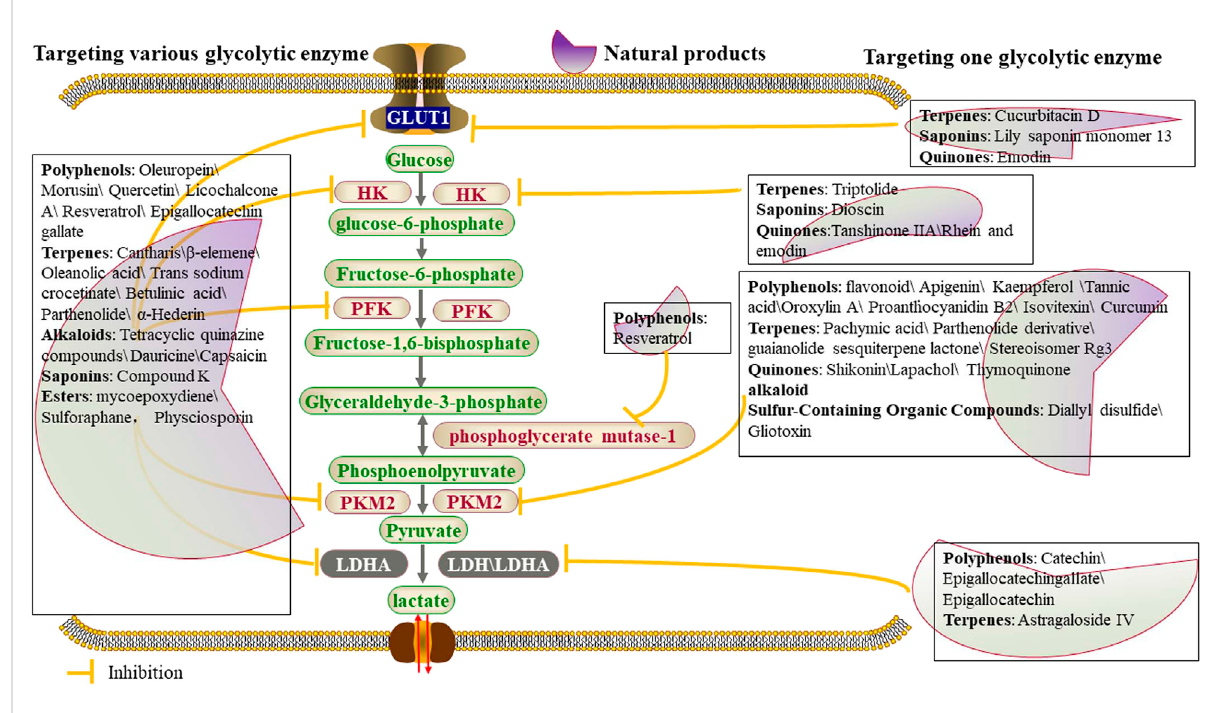
FIGURE 2 Natural products affect glycolysis in tumor cells by directly regulating glycolytic